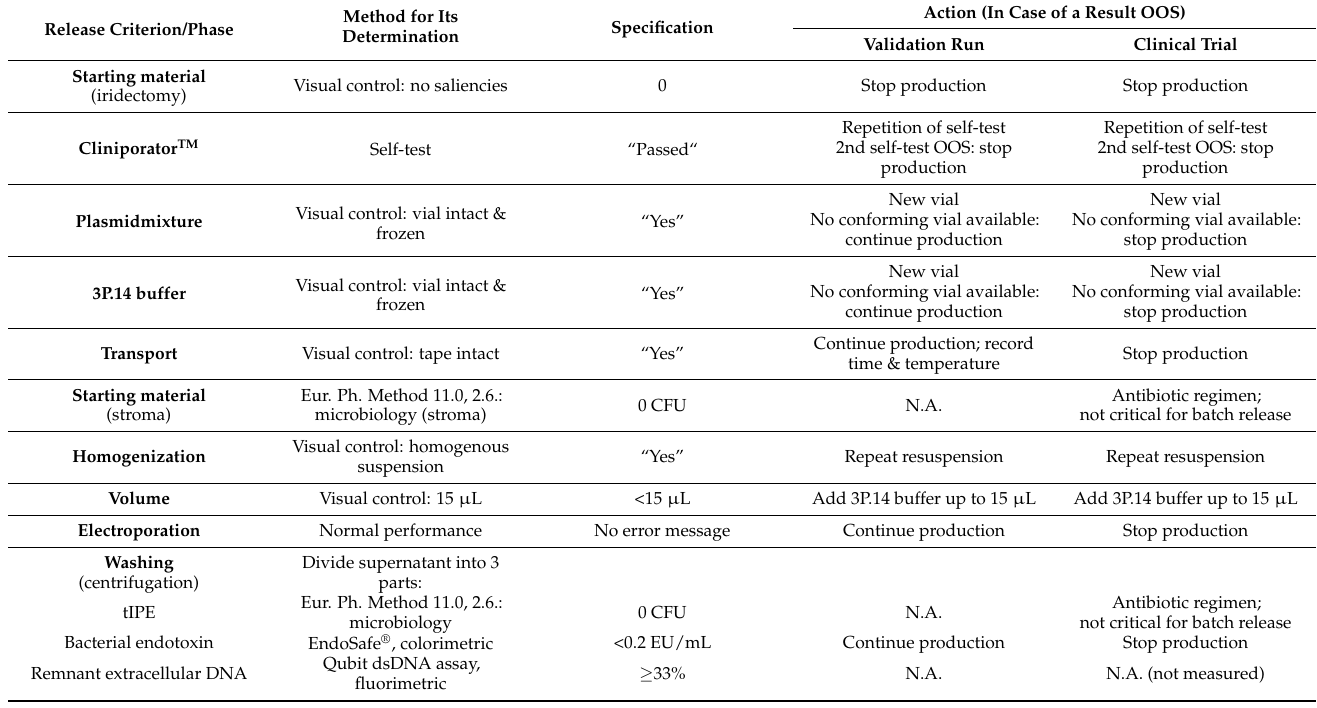
Table 4. QC and specifications defined for tIPE manufacturing during validation. List of controls performed during validation as shown in Figure 4 (compared to controls planned to be performed in the clinical trial), the methods used and their importance for batch release. Generally, all used consumables including the sterile single use electroporation cuvettes were verified for package integrity, expiration date, and lot numbers were documented. N.A. = not